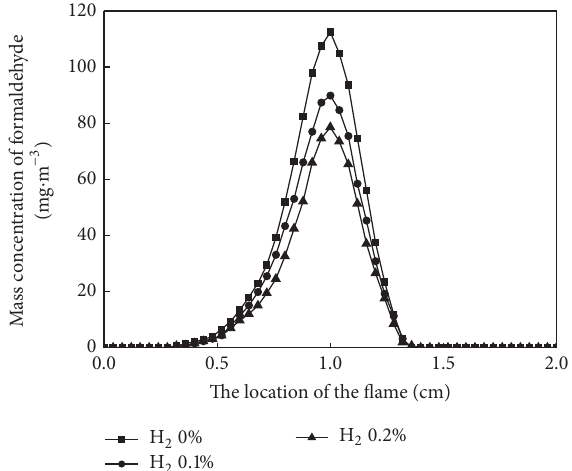
Figure 7: Influence of the addition of H 2 on formaldehyde emission for